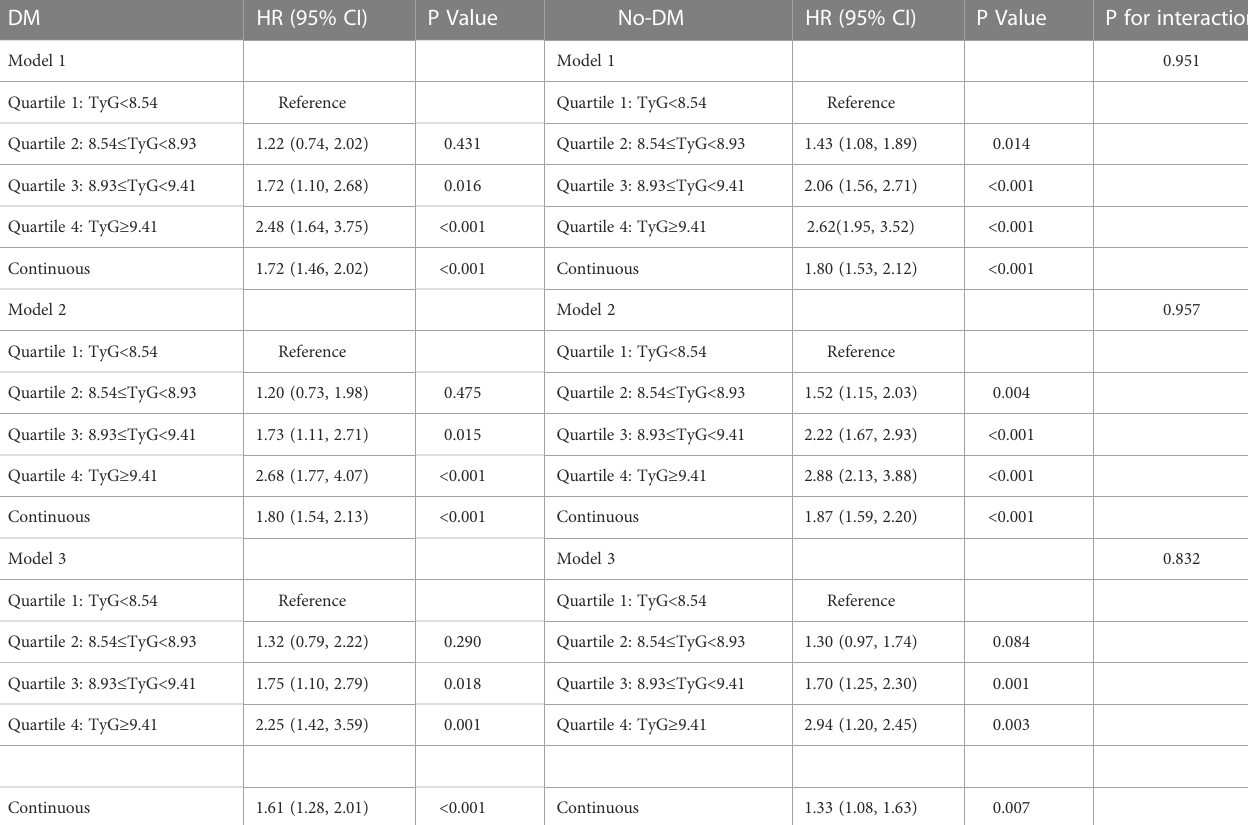
TABLE 4 The association between TyG and MACE in patients with DM or